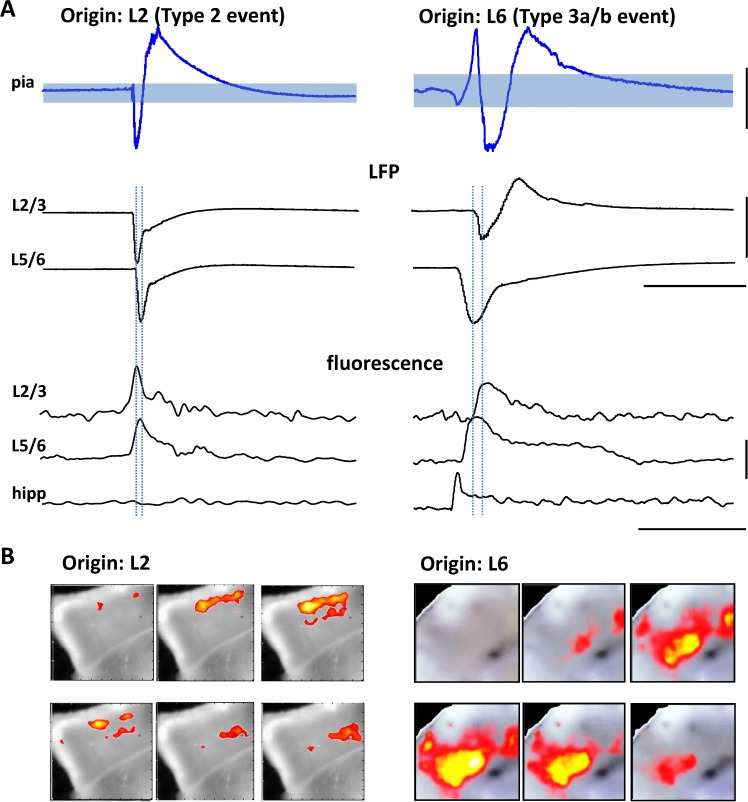
Laminar origin of local and hippocampally-projected neocortical discharges is reflected in the electrographic waveform structure.
A. Upper traces. Average of 12 events measured with an extracellular electrode at the pia to model non-invasive cortical recordings (pia). Shaded region represents +/- 2 SD of the mean trace shown. Note the overt biphasic vs. triphasic shape of the electrographic events when comparing interictal-like discharges of neocortical vs. hippocampal origin respectively. Middle traces. Concurrent superficial (L2/3) and deep (L5/6) cortical local field potential (LFP) recordings showing different laminar onsets. Lower traces. Example 2x2-binned fluorescence changes for the two event types. Scale bars 20μV (upper), 0.2 mV (middle), 0.1% ΔF (lower), 0.5 sec. B. Selected frames from the events in A showing the sequence of spatiotemporal activation for the two interictal-like events. Note the more overt, diffuse activation of deep layers for events propagated from hippocampus.